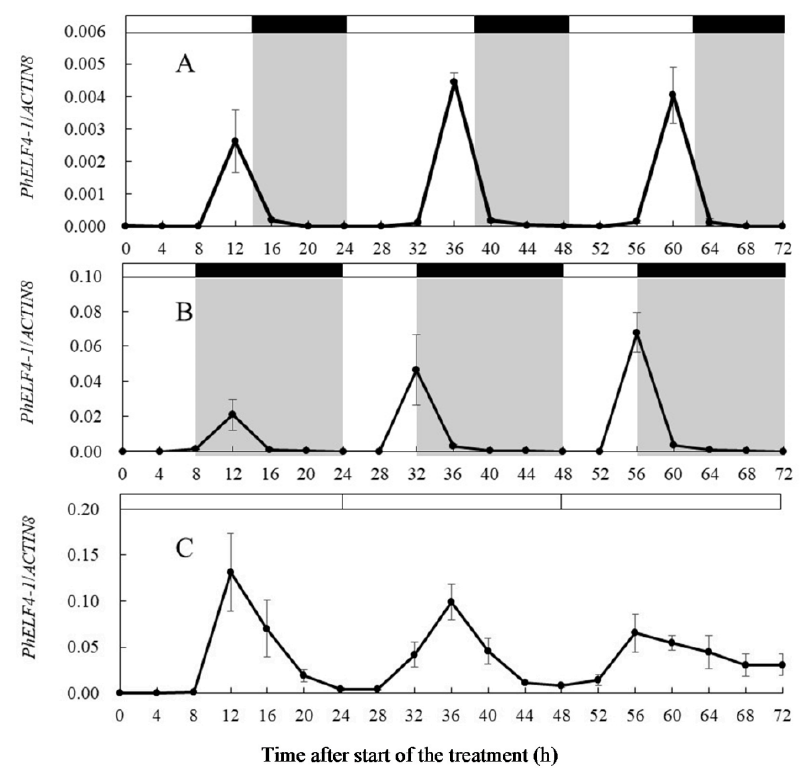
Figure 5. Expression of PhELF4-1 in petunia plants grown under di ff erent photoperiods with blue light from light emitting diodes as analyzed by real-time quantitative PCR. ( A ): 14 h light / 10 h dark, ( B ): 8 h light / 16 h dark, ( C ): 24 h light / 0 h dark. White and black bars at the top of each graph indicate light (day) and dark (night) periods, respectively. The expression was normalized to the expression of the PhACTIN 8 gene. The error bars show SE ( n =